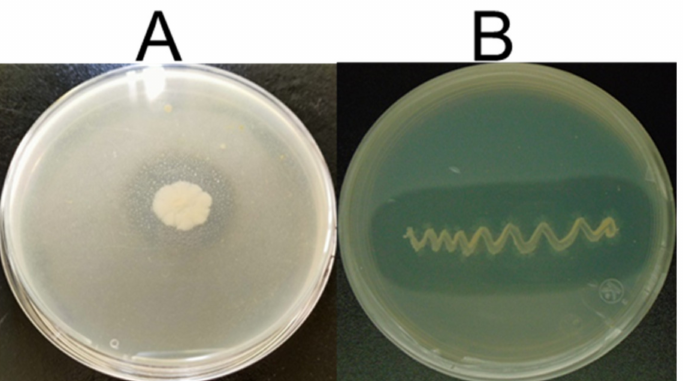
Figure 1. Preliminary screening of keratinase production by two strains ( A ) S. netropsis A-ICA; ( B ) B. subtilis ALICA exhibiting zone of hydrolysis around the colonies on the casein